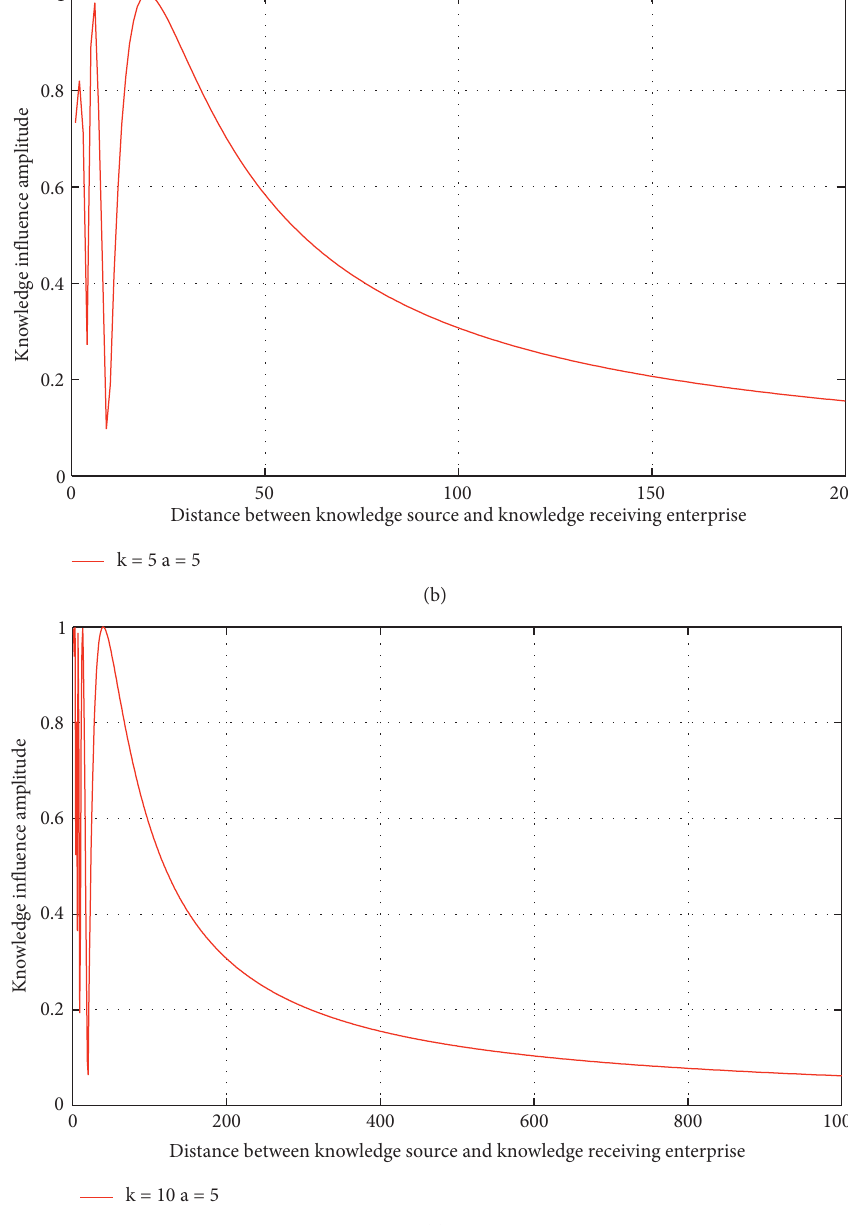
Figure 14: Distributions of the influence amplitude in the knowledge field when a � 5 and k � 2 , 5 ,